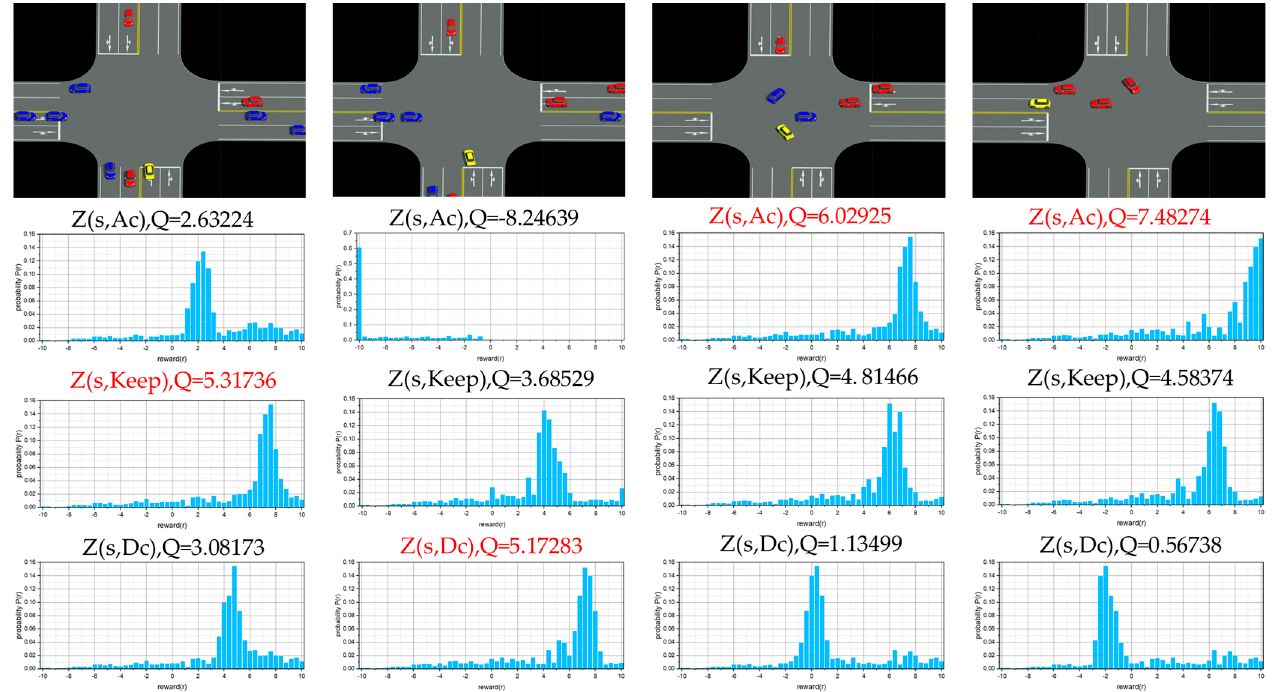
Figure 16. Intelligent vehicles make driving decisions through state-action value distribution.